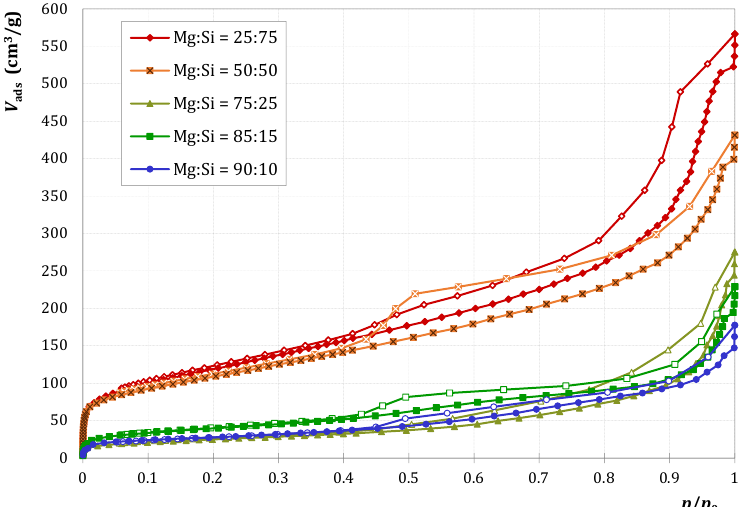
Figure 2. Nitrogen adsorption and desorption at 77 K on M1 / SiO 2 mixed oxide samples with various compositions.